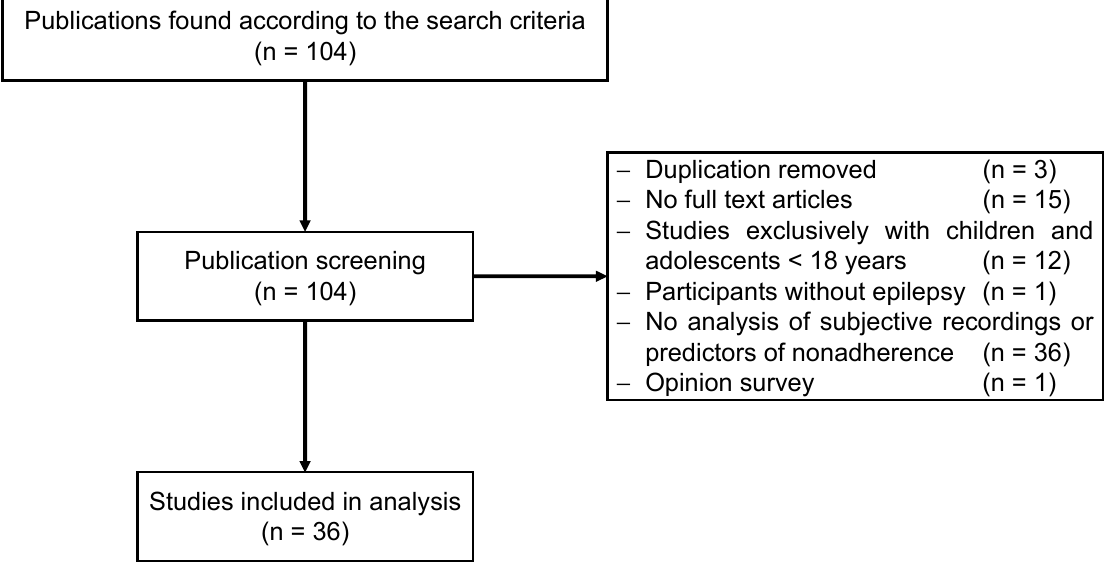
Figure 1. Flow diagram of selection.